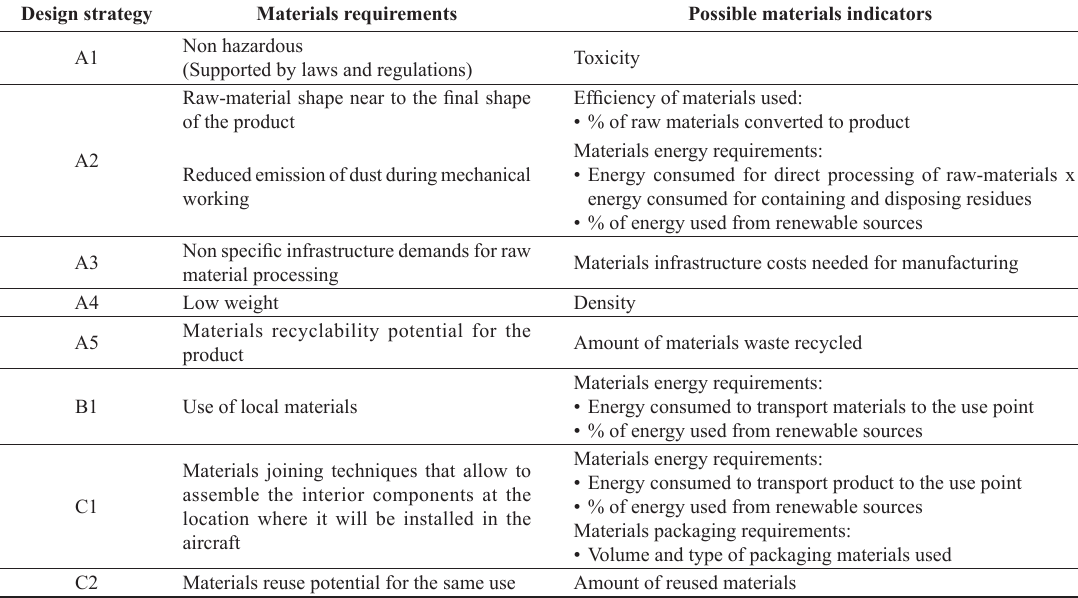
Table 3: Exploring materials requirements and indicators to design sustainable aircraft interiors, from mapping